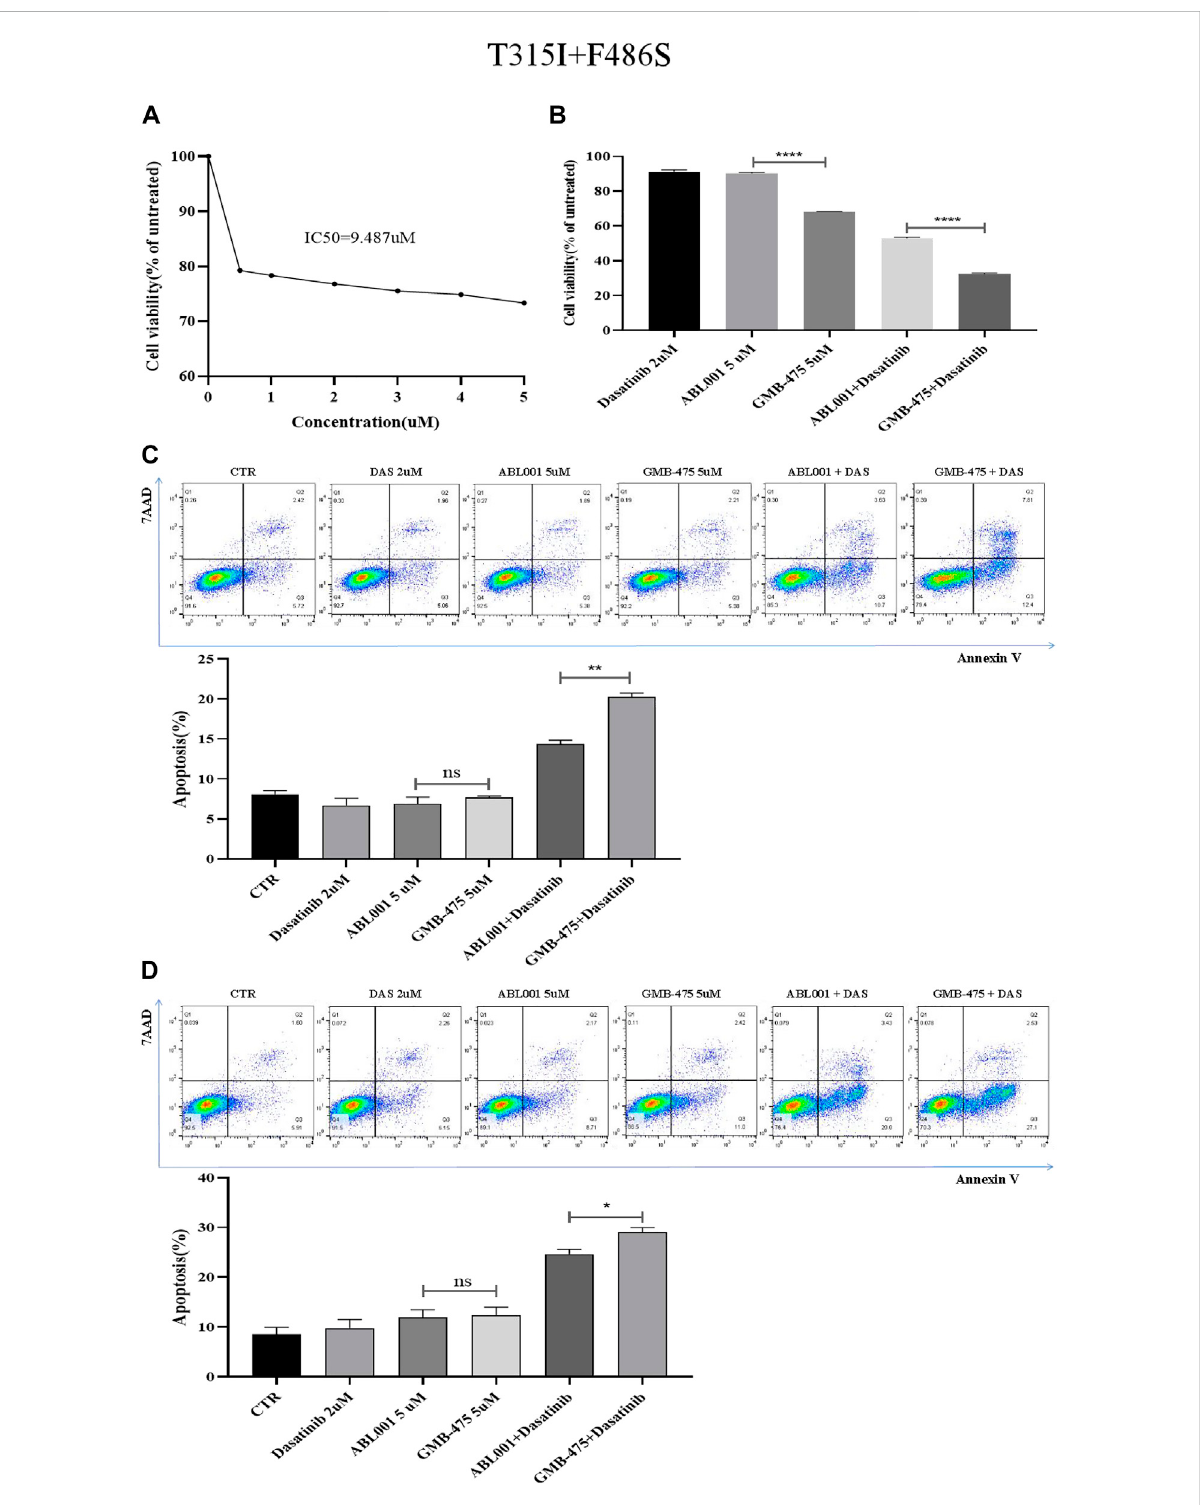
GMB-475 combined with dasatinib exhibited a better synergistic effect on Ba/F3-MIG-p210 cells carrying BCR::ABL1 T315I+F486S mutations compared with ABL001. (A) Ba/F3-MIG-p210 cells were treated with different concentrations of ABL001 for 48 h, and cell viability was detected using the CCK8 assay. (B) The viability of Ba/F3-MIG-p210 cells treated with dasatinib 2 µM, ABL001 5 µM, GMB-475 5 µM, ABL001 5 µM plus dasatinib2 µM,andGMB-4755 µMplusdasatinib2 µMfor24 hwasdetectedusingtheCCK8assay. (C)